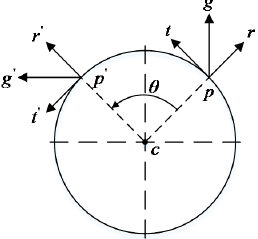
Figure 6. Illustration of radial gradient transform. For the given radial coordinate system ( r , t ), when the chip is rotated by θ , the projections of the gradient in ( r , t ) remain the same.